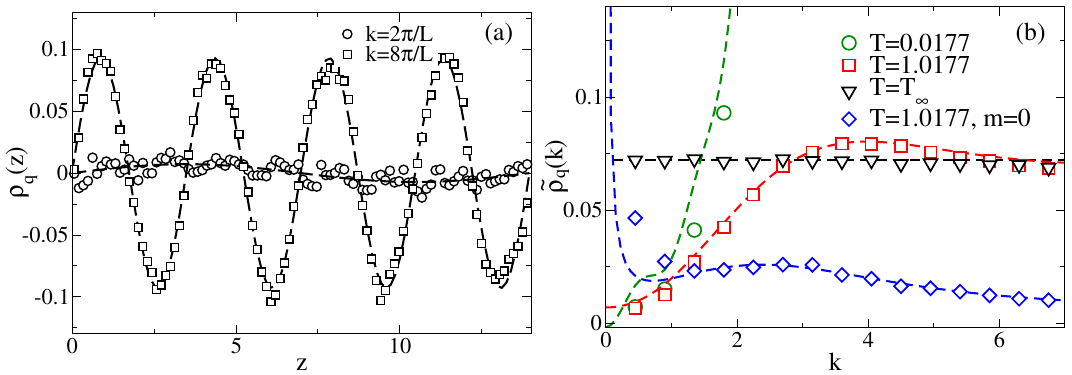
Figure 4: Non-equilibrium results for molten salt (a) Charge density profiles for T = 0.0177. ρ = 0.0072 and 0.093, values obtained from a Lines are sine functions with amplitudes (cid:101) q spectral analysis. (b) Charge density amplitudes for all three temperatures and for m = 0. Symbols are simulation results. Lines are predictions from the theory, Eq.